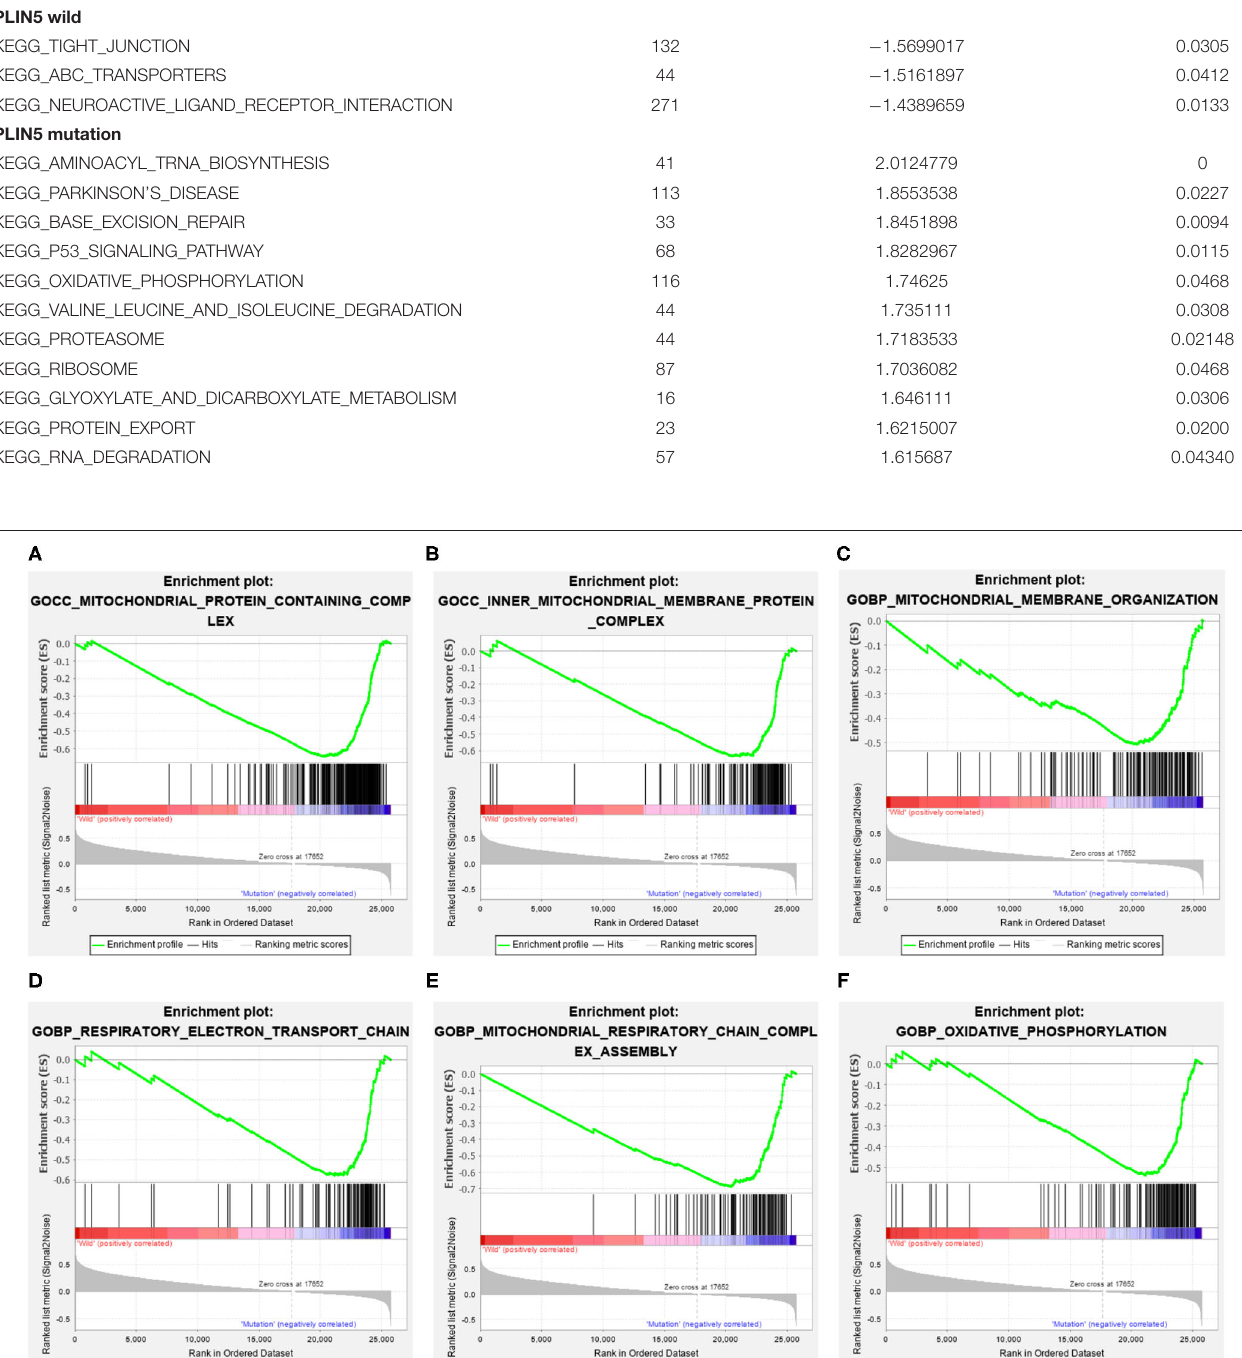
Frontiers in Medicine |